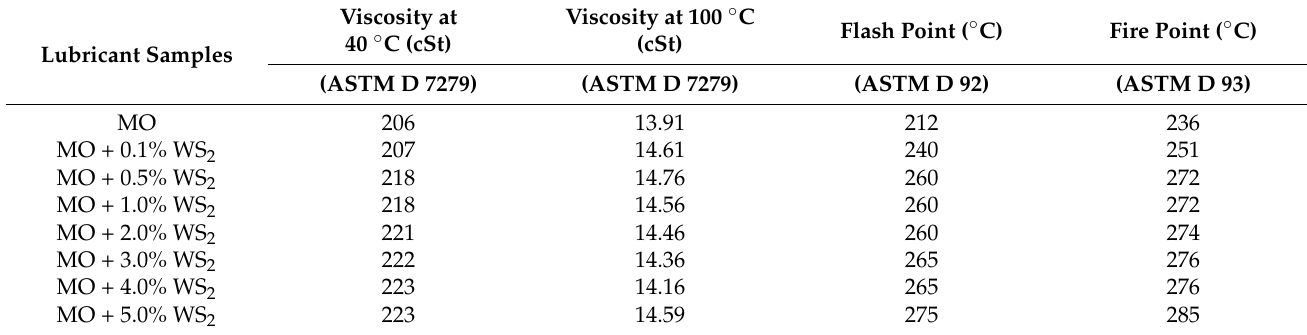
Table 1. Physico-chemical properties of the lubricant